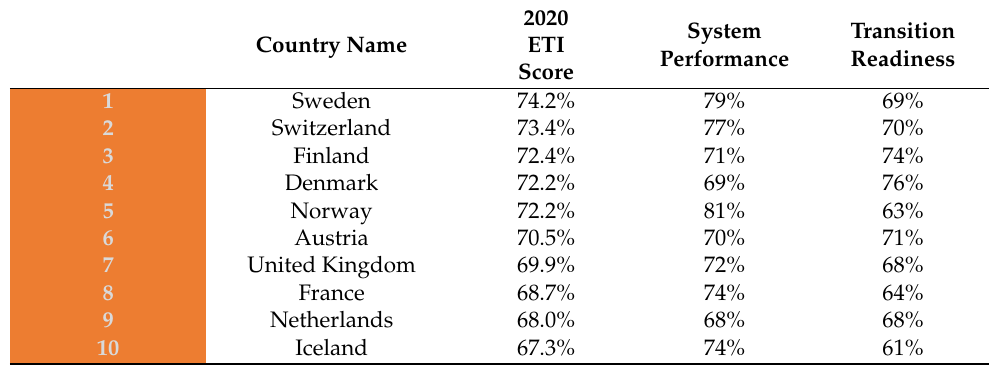
Table 3. ETI ranking